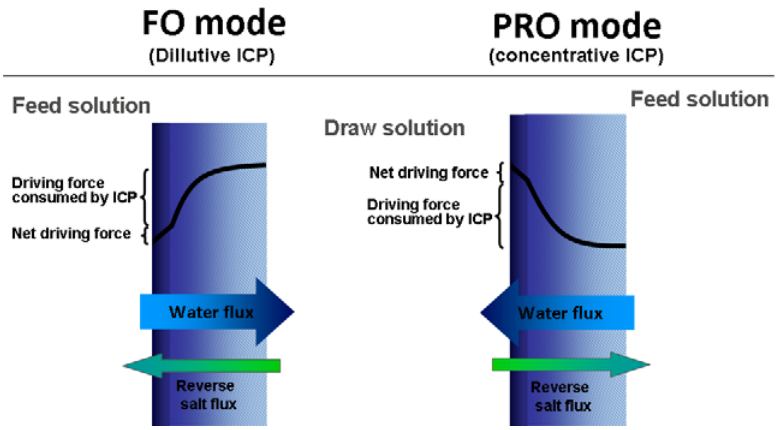
Figure 5. Illustration of dilutive and concentrative internal concentration polarization (ICP). Figure adapted from